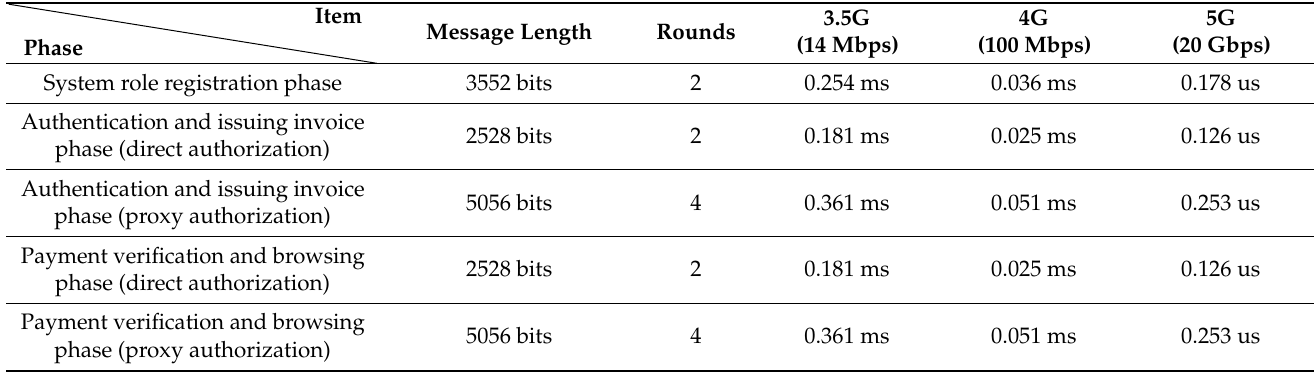
Table 3. Communication cost analysis of our scheme.